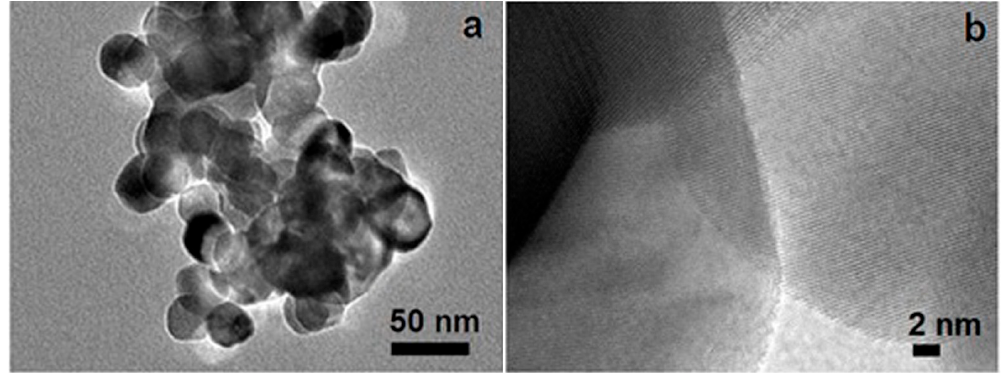
Figure 1. ( a ) Transmission electron microscopy (TEM) and ( b ) high ‐ resolution transmission electron microscopy (HRTEM) image of copper oxide (CuO)/cerium oxide (CeO 2 ) nanocomposite.